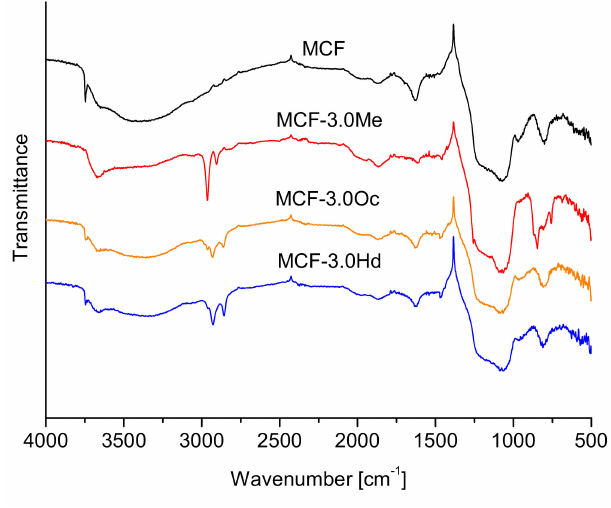
Figure 1. FTIR spectra of the pristine MCF and after grafting with: methyl (Me), octyl (Oc), and hexadecyl (Hd)